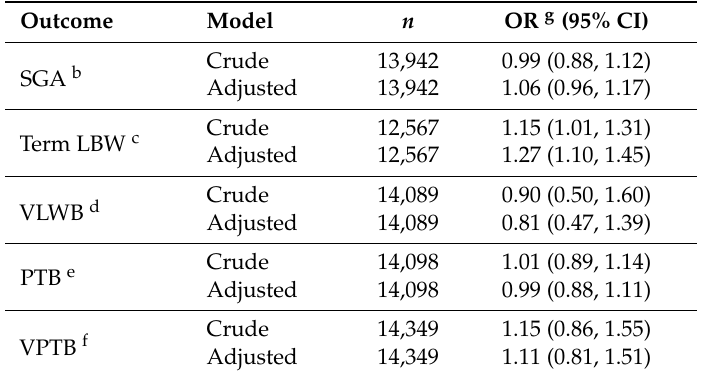
Table 3. Associations a between gestational mean atrazine concentrations in drinking water and SGA, term LBW, VLBW, PTB, and VPTB in AMP communities ( n = 22) in Ohio, 2006–2008.